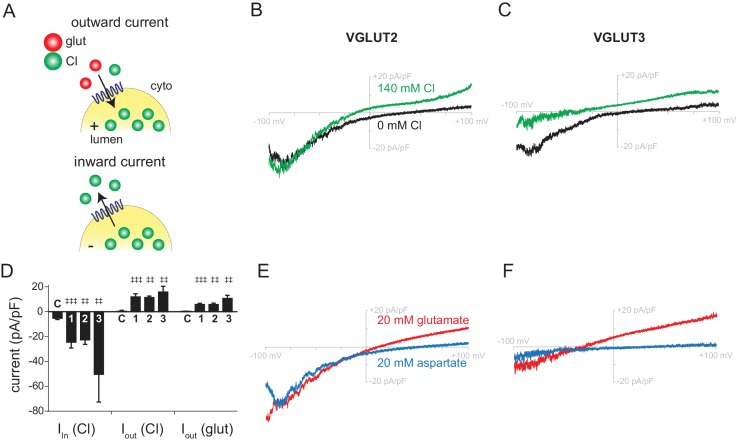
Chloride and glutamate currents (with lumenal NPPB) in VGLUT2+ and VGLUT3+ endosomes.(A) Whole endosome recording conditions with 140 mM Cl- at pH 5.0 and 200 µM NPPB in the pipette (lumen). Representative recordings from endosomes expressing VGLUT2 (B,E) and VGLUT3 (C,F). The top (A,B) and bottom (C,D) recordings were made from the same endosome, demonstrating inward and outward Cl- currents (top) and outward glutamate currents (bottom). The compiled data from multiple endosomes are shown in D, the currents defined as in Figure 1—figure supplement 1 and statistical comparisons made to control (C). (n = 5–9). Bar graph indicates mean ± SEM. ‡‡p<0.001, ‡‡‡p<0.0001 by Mann-Whitney test.